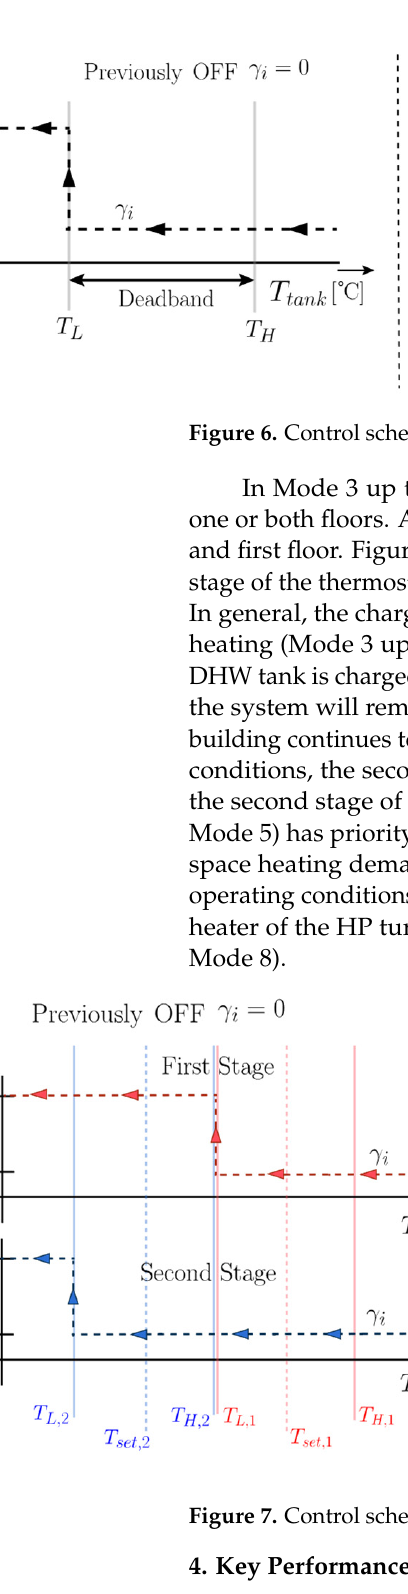
Figure 8. PVT-HP reference system configuration implemented in the Template Solar System of IEA SHC Task 32. 4.1. Seasonal Performance Factor The Seasonal Performance Factor ( SPF ) is a dimensionless measure of the energy ef- ficiency of the PVT-HP system. The SPF is the ratio of the useful thermal energy output of the system to the electrical energy input to the system: 𝑆𝑃𝐹 (cid:3046)(cid:3052)(cid:3046) = (cid:1516)(cid:3435)𝑄(cid:4662) (cid:3020)(cid:3009) + 𝑄(cid:4662) (cid:3005)(cid:3009)(cid:3024) (cid:3439) ∙ 𝑑𝑡 (cid:1516) 𝑃 (cid:3046)(cid:3052)(cid:3046) ∙ 𝑑𝑡